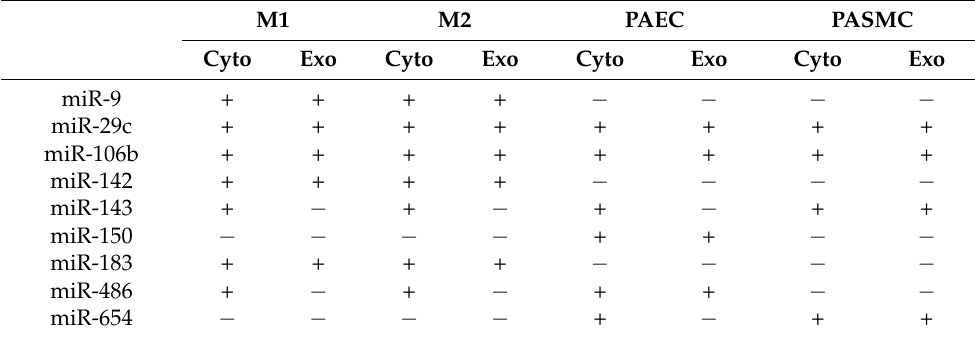
Table 3. Source of miRNAs. The miRNA expression was detected (+, yes; − , no) in macrophages, polarized into M1 and M2, endothelial cells (PAECs) and smooth muscle cells (PASMCs) in their respective cellular extracts (Cyto) and exosomes (Exo). MiR-103a was detected in all samples and used as internal reference. M1 M2 PAEC PASMC Cyto Exo